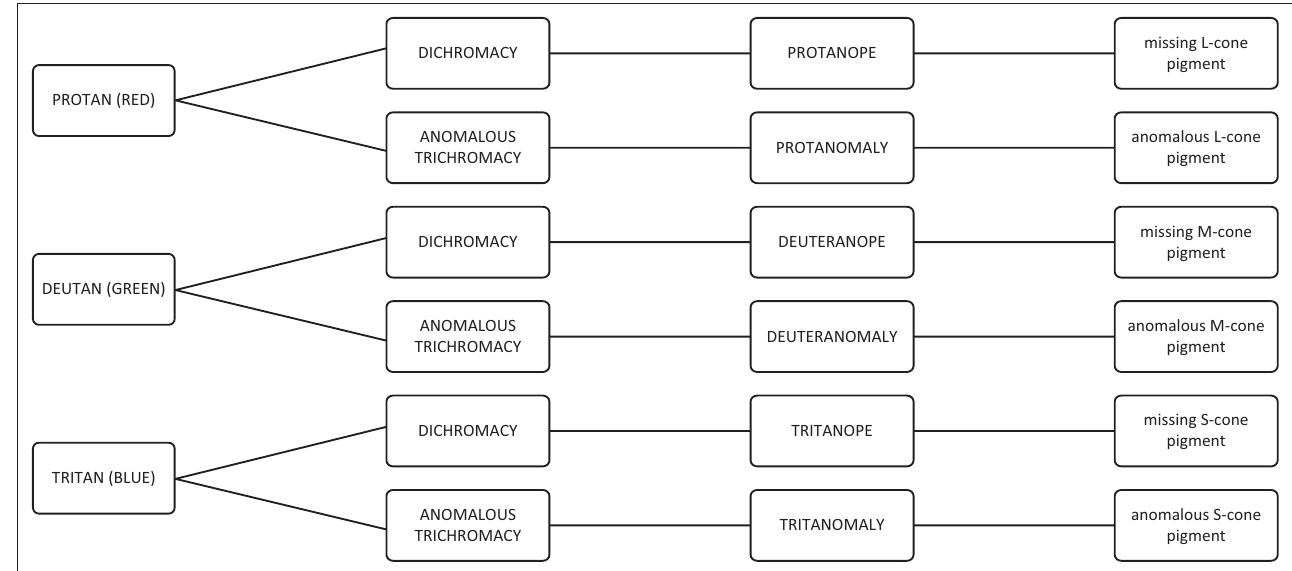
FIGURE 1: Flow diagram illustrating colour vision